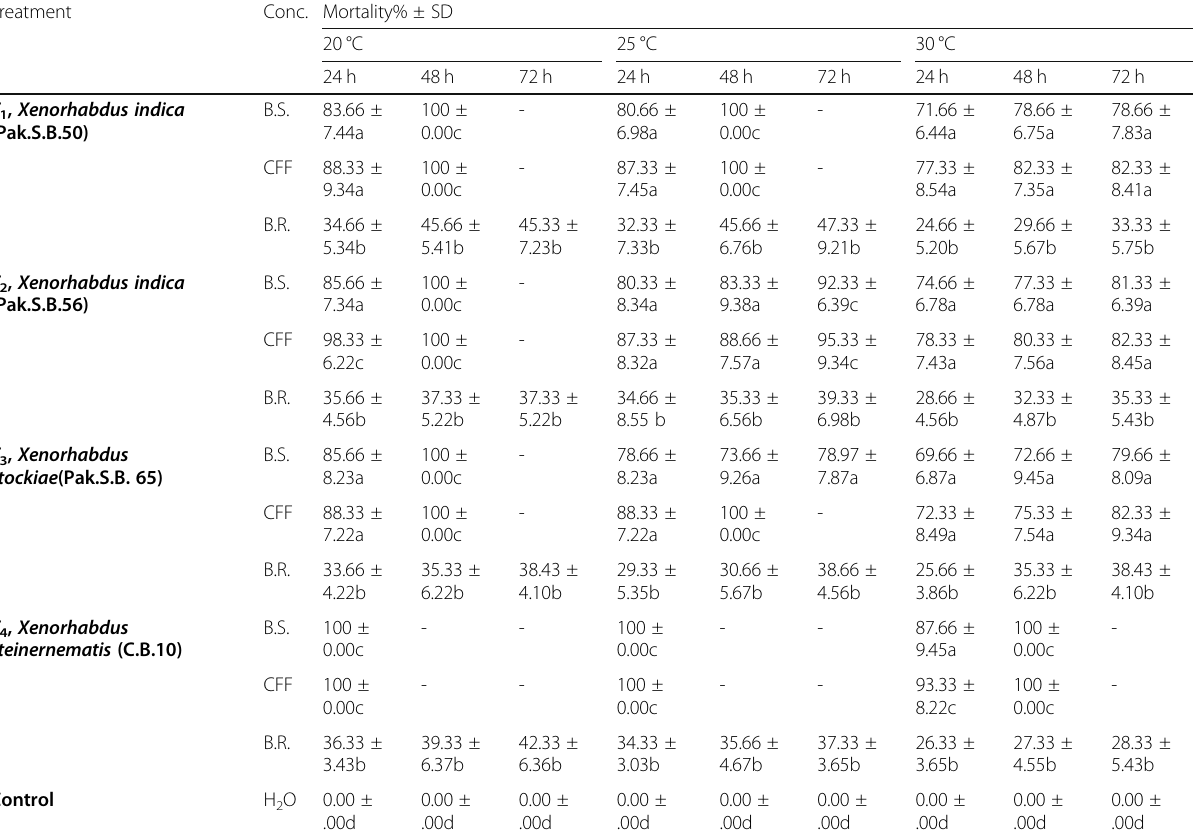
Table 3 Influence of different bacterial fractions on the mortality of termites in relation to temperature and time duration by spray method Treatment